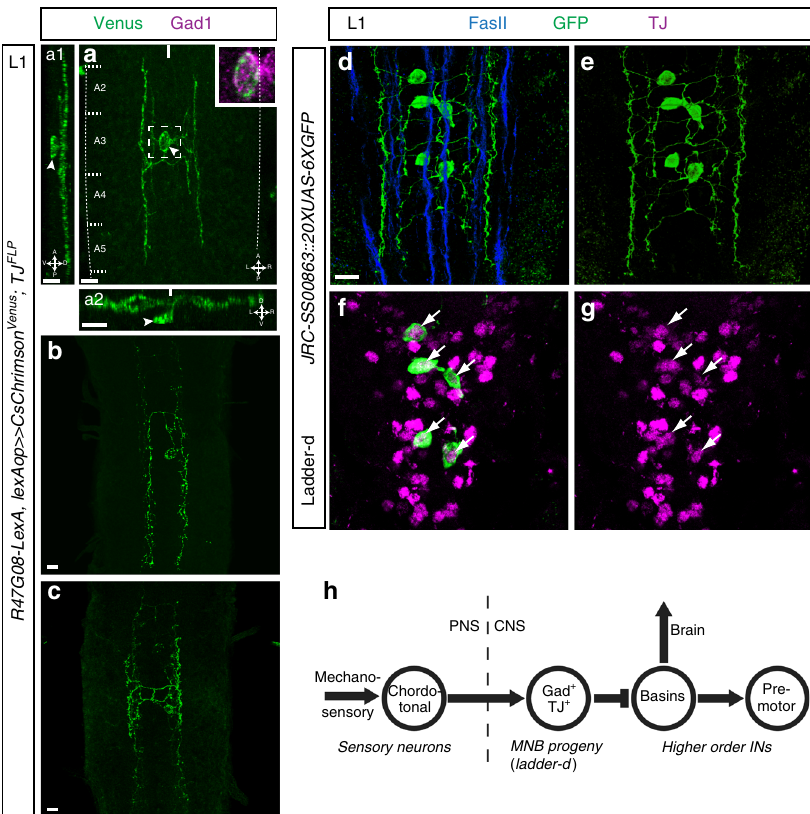
Fig. 10 The TJ + MNB neurons are Ladder neurons. a 3D reconstruction of a fi rst instar larva VNC stained for Gad1 (magenta) and showing the morphology of a single GABAergic TJ + MNB progeny neuron (arrowhead, expressing Venus under the combined expression of TJ-Flp and R47G08-lexA ) in dorsal view ( a ), lateral view ( a1 ), and posterior view ( a2 ). For all three views ( a , a1 , a2 ), the magenta channel (Gad1 staining) was omitted to allow a better observation of the MNB progeny neuron morphology. Close-up in a con fi rms that the TJ + MNB progeny neuron shown is indeed GABAergic. b , c Dorsal projection of fi rst instar larva single MNB progeny neurons. d – g 3D reconstruction of a fi rst instar larva VNC showing the morphology of Ladder-d neurons visualized using the split Gal4 line JRC-SS00863 driving 20XUAS-6XGFP and stained for FasII and TJ. f , g Single confocal sections through the soma showing that Ladder-d neurons express TJ (arrows). h Proposed circuit for TJ + /Gad1 + MNB progeny-dependent modulation of the speed of